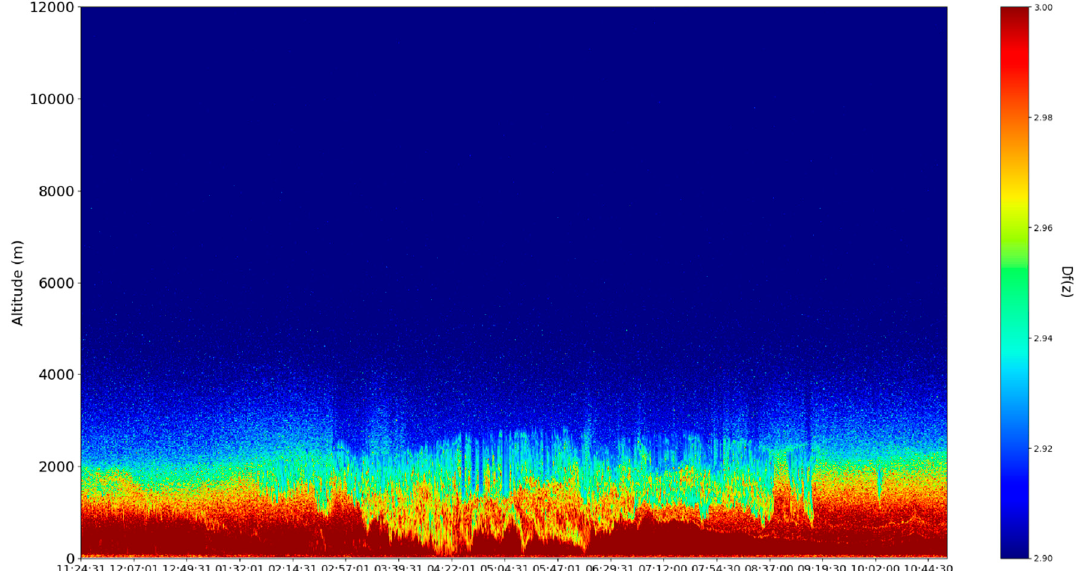
Figure 21. D (cid:2916) time series, λ = 1064 nm , Gala ț i, Romania, 23 December 2021. Figure 21. D f time series, λ = 1064 nm, Galat i, Romania, 23 December 2021. Figure 21. D , (cid:2916) time series, λ = 1064 nm , Gala ț i, Romania, 23 December 2021.